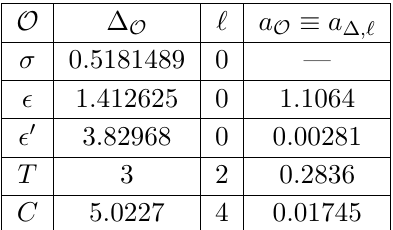
Table 1 . Low lying operators in the 3d Ising model. The OPE data refers to couplings in the spin-field four-point correlator, i.e. a ∆ ,‘ = λ 2 . Data taken from [3]. σσ O ∆ ,‘ √ √ with ρ ( z ) = (1 − 1 − z ) / (1 + 1 − z ) . This allows us to define a resummed